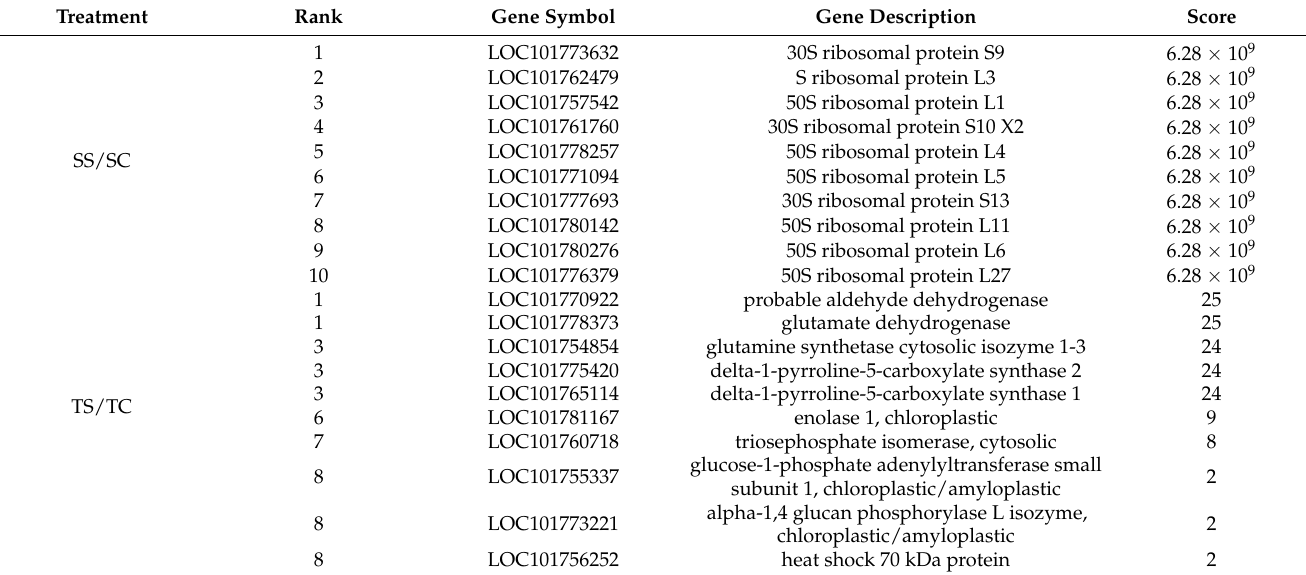
Table 2. Hub gene information by maximal clique centrality